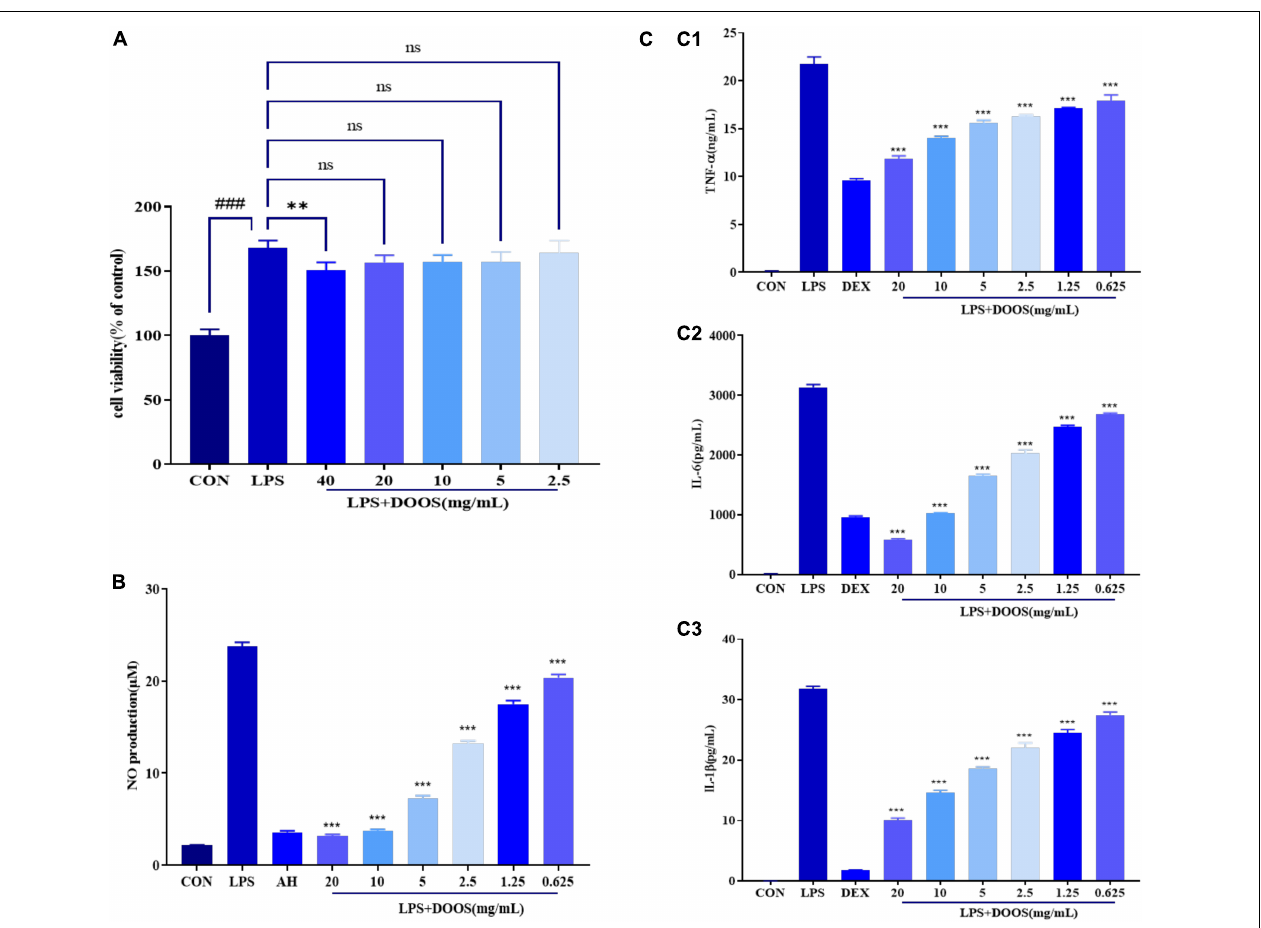
FIGURE 4 | (A) Effect of DOOS on the viability of RAW 264.7 cells. RAW 264.7 cells were incubated with different concentrations of DOOS and LPS (1 µ g/mL) for 24 h. Cell viability was determined by CCK-8 assay. (B) Effects of DOOS on the production of NO in LPS-induced RAW 264.7 cells. The cells were treated with different concentrations of DOOS for 1 h prior to stimulation and LPS (1 µ g/mL) for 24 h. (C) Effects of DOOS on TNF- α (C1) , IL-6 (C2) , and IL-1 β (C3) secretion. The cells were treated with different concentrations of DOOS for 1 h prior to stimulation and LPS (1 µ g/mL) for 24 h. Then the supernatant was collected to test cytokines production by ELISA. Values show the means and standard deviations of different concentrations performed in triplicate. *** p < 0.001 and ** p < 0.01 vs. LPS group; ns, no significance; ### p < 0.001 vs. control